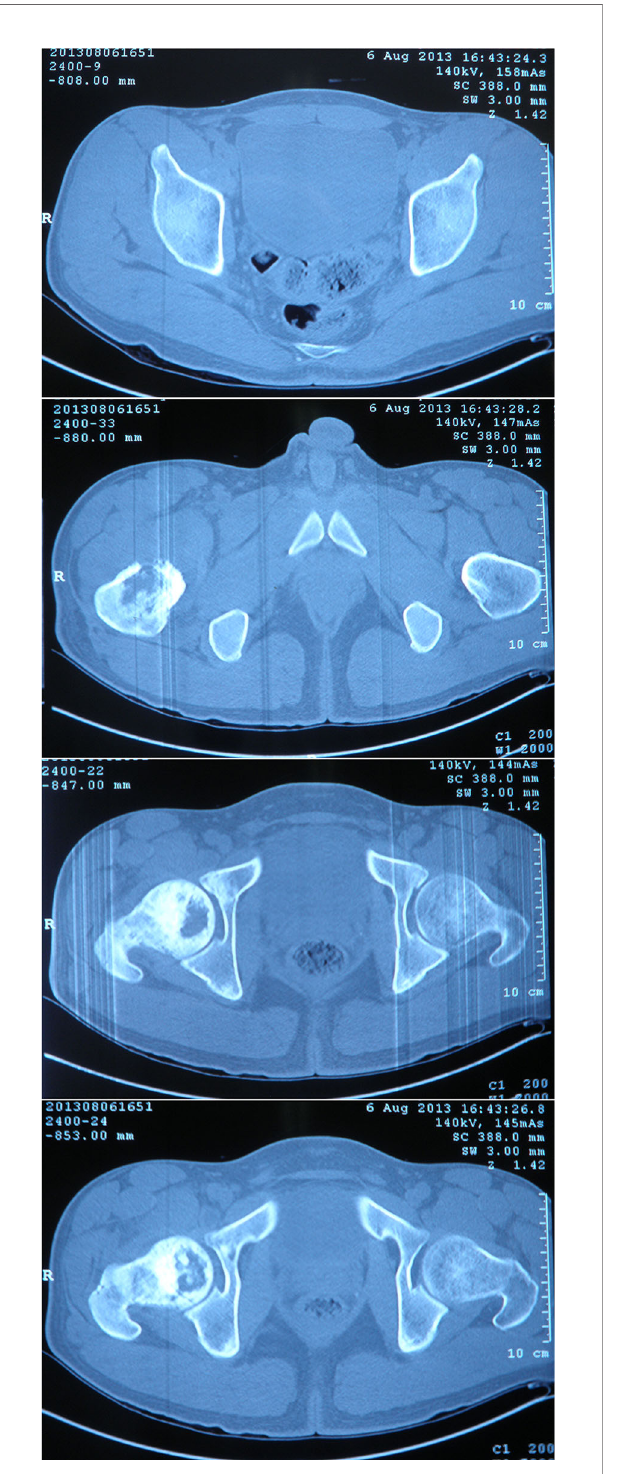
FIGURE 2 | CT scan of pelvis at the fi rst week of onset demonstrated a permeative pattern of bone destruction in the femerol head and neck which poorly marginated with laminar periosteal reaction. A high bone density lesion was detected under the articular surface of right acetabulum. The breadth of the joint space was normal.